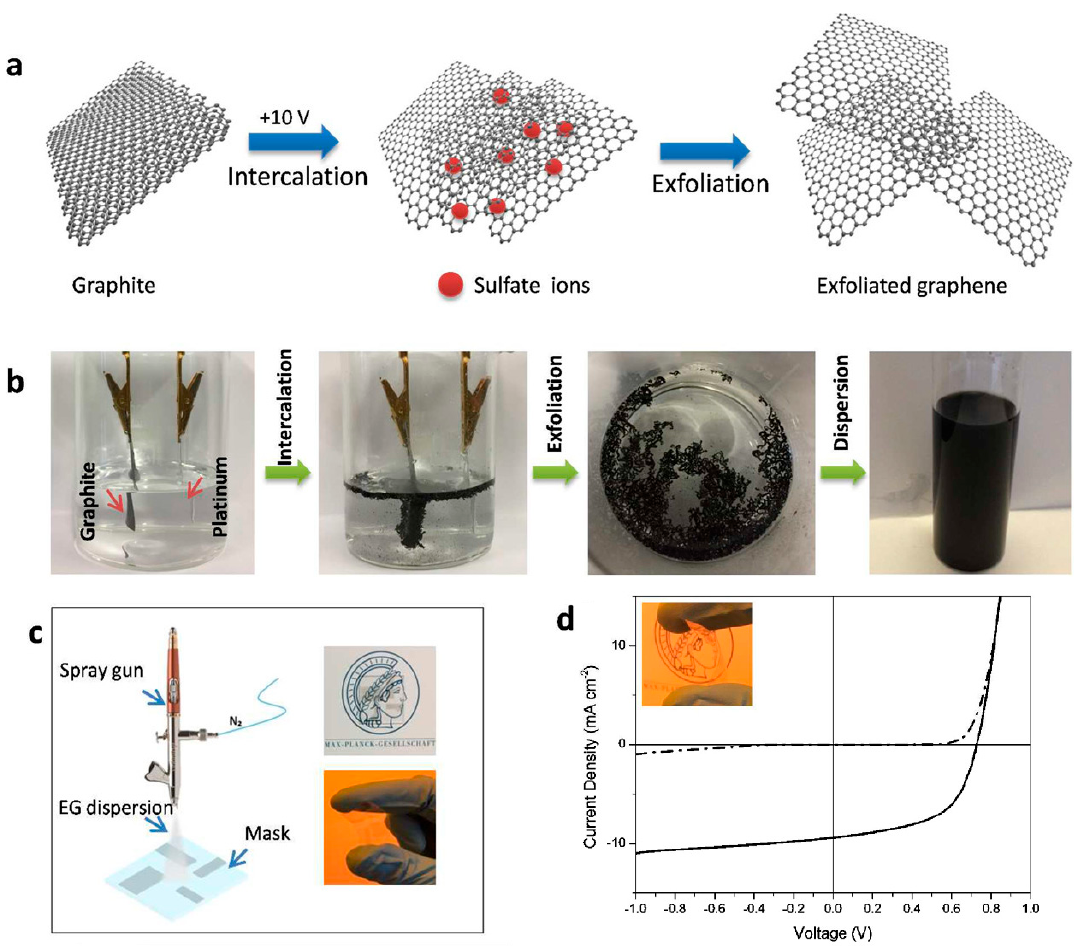
Figure 4. ( a ) Scheme of the electrochemical exfoliation of graphite; ( b ) optical images of the exfoliation process; ( c ) schematic representation of spray deposition of exfoliated graphene (EG) dispersion onto poly(ethylene 2,6-naphthalate) (PEN); ( d ) J–V characteristics of the cell under light (solid line) and dark conditions (dashed line). Reprinted with permission from [55].